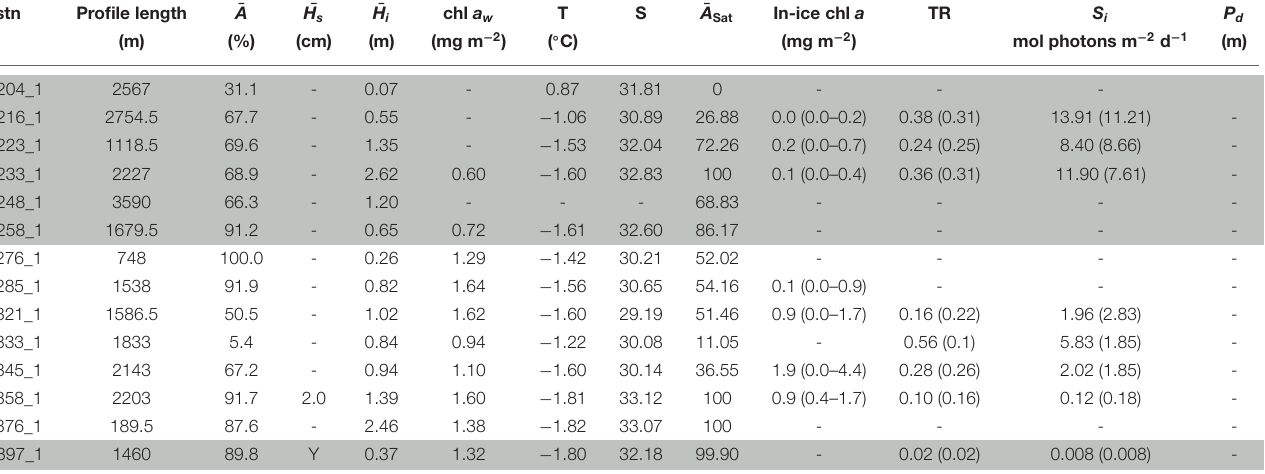
TABLE 5 | Table for PS80 with, for each station (stn), the total profile length, the mean ice concentration ( ¯ A ) along profile, mean snow depth ( ¯ H s ) and mean total ice thickness ( ¯ H i ), under-ice water chl a (chl a w ) multiplied by the vertical section of the SUIT (2m) to obtain integrated values, under-ice water temperature and salinity, ice concentration retrieved from satellite ( ¯ A Sat ), and median in-ice chl a (interquartile range), mean transmittance TR ( ± one standard deviation), mean Insolation S i ( ± one standard deviation), and the draft patch size ( P d ).